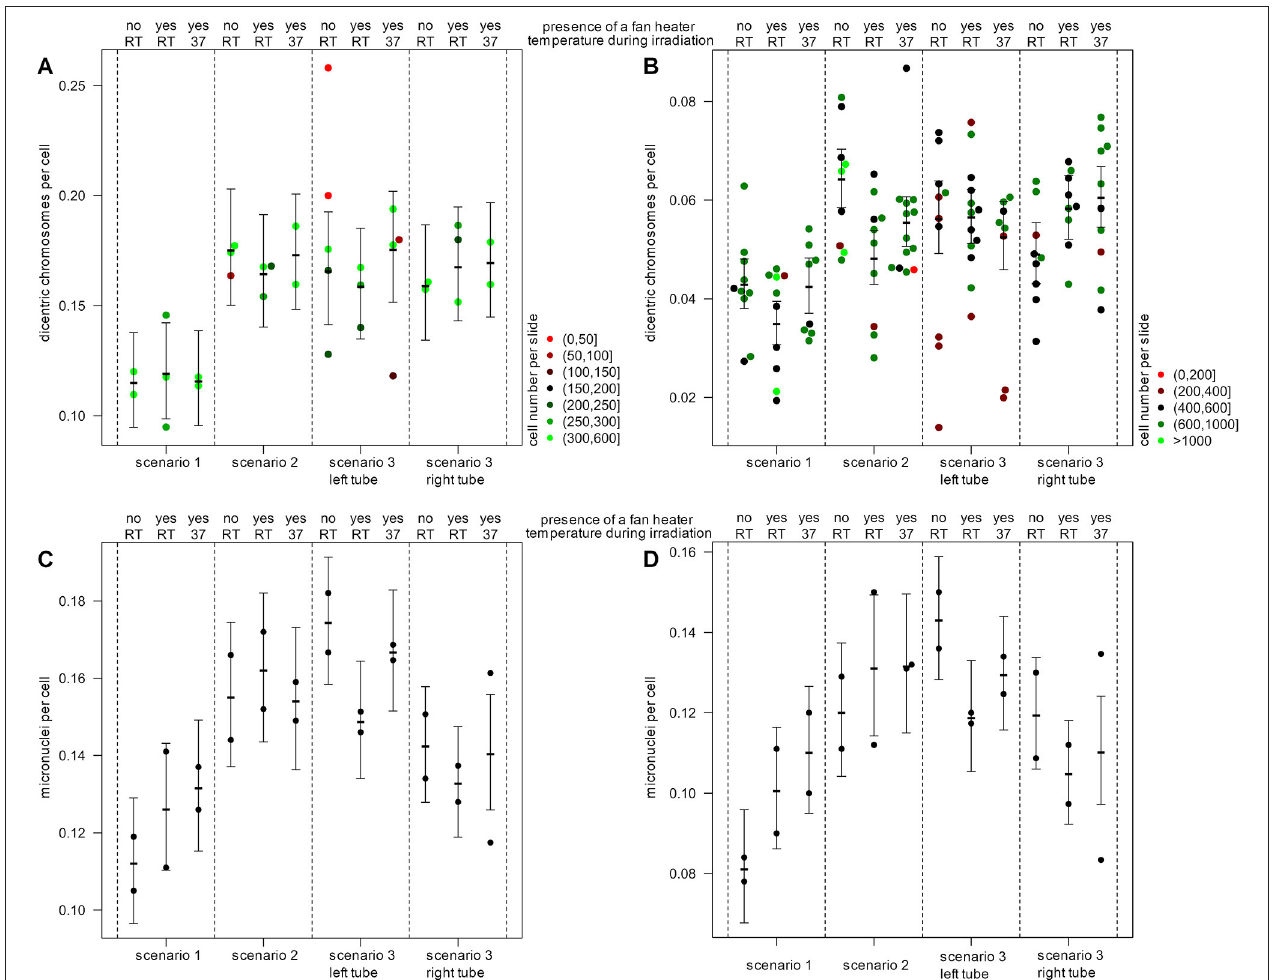
FIGURE 3 | Effects of experimental setup on biological endpoints. The number of dicentric chromosomes for (A) manual and (B) semi-automatic quantification and the number of micronuclei for (C) manual and (D) semi-automatic quantification is illustrated. Shown is the mean number of damages per cell and per slide and for each scenario with the 95% confidence interval. The number of evaluated cells per slide is color-coded for dicentric chromosomes (red to green) for the analysis of micronuclei, 1,000 cells per slide were used. Blood samples were irradiated in the center of the beam area in the presence or absence of a fan heater and at different temperatures (37 ◦ C) or room temperature